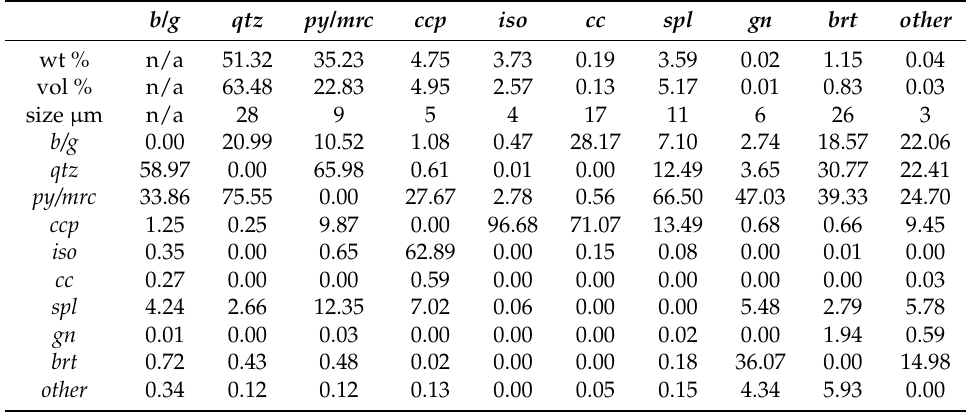
Table 3. Summary (reading down, then left) of mineralogical associations of mineralised material identified by QEMSCAN (1 µ m resolution). Mineral abbreviations after [43]. iso is isocubanite. b/g